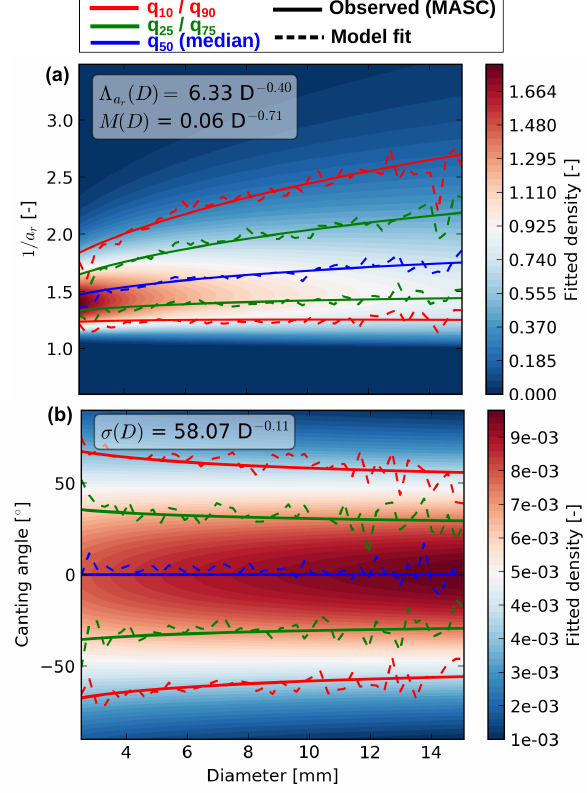
Figure 6. Fitted probability density functions for the inverse of the aspect-ratio (a) and the canting angle (b) . The power-laws relat- ing the particle density function parameters to the diameter are dis- played in the grey boxes on the top-left. Note that the fit was per- formed on the inverse of the aspect-ratio (major axis over minor